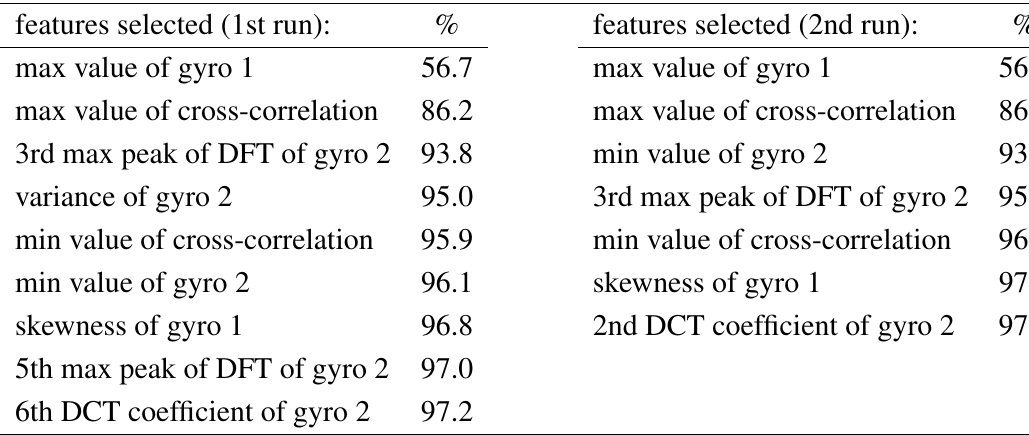
Table 2. Sample SFFS results where average correct classification rates over all classification techniques are given for two different